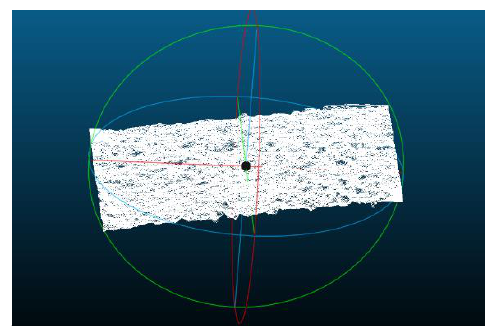
Figure 19.The dense point cloud of spalled concrete